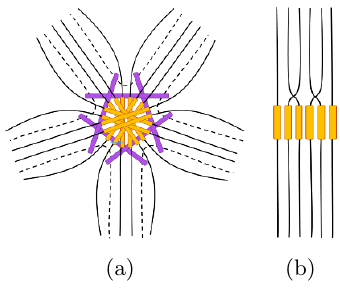
Figure 39 . (a) Tensor T and (b) Tensor E for the tensor network with f 4 ; 5 g tiling and